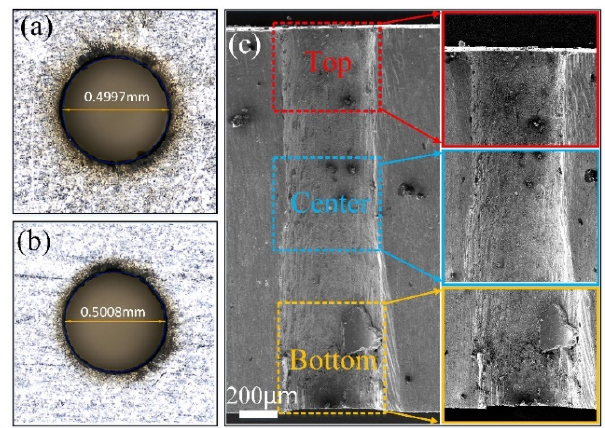
Figure 6. Morphology of microholes with a taper angle of 0.03 ◦ : ( a ) microhole entrance; ( b ) microhole exit; ( c ) microhole cross section. Table 3. Mass ratios of different elements at the top, center and bottom of the microhole cross section. Element Top Centre Bottom